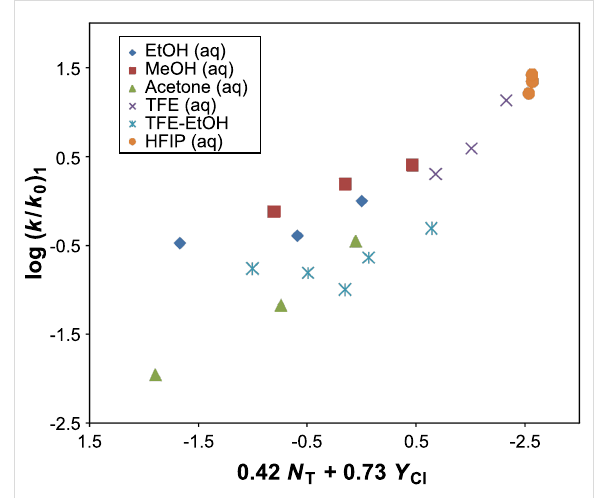
Figure 4: The plot of log ( k / k 0 ) for isobutyl chlorothioformate ( 2 ) against 0.42 N T + 0.73 Y Cl in 15 pure and binary solvents. The points for the 100% EtOH, 90% EtOH, 100% MeOH, 90% MeOH, and 20% T-80% E were not included in the correlation. They are added to show the extent of their